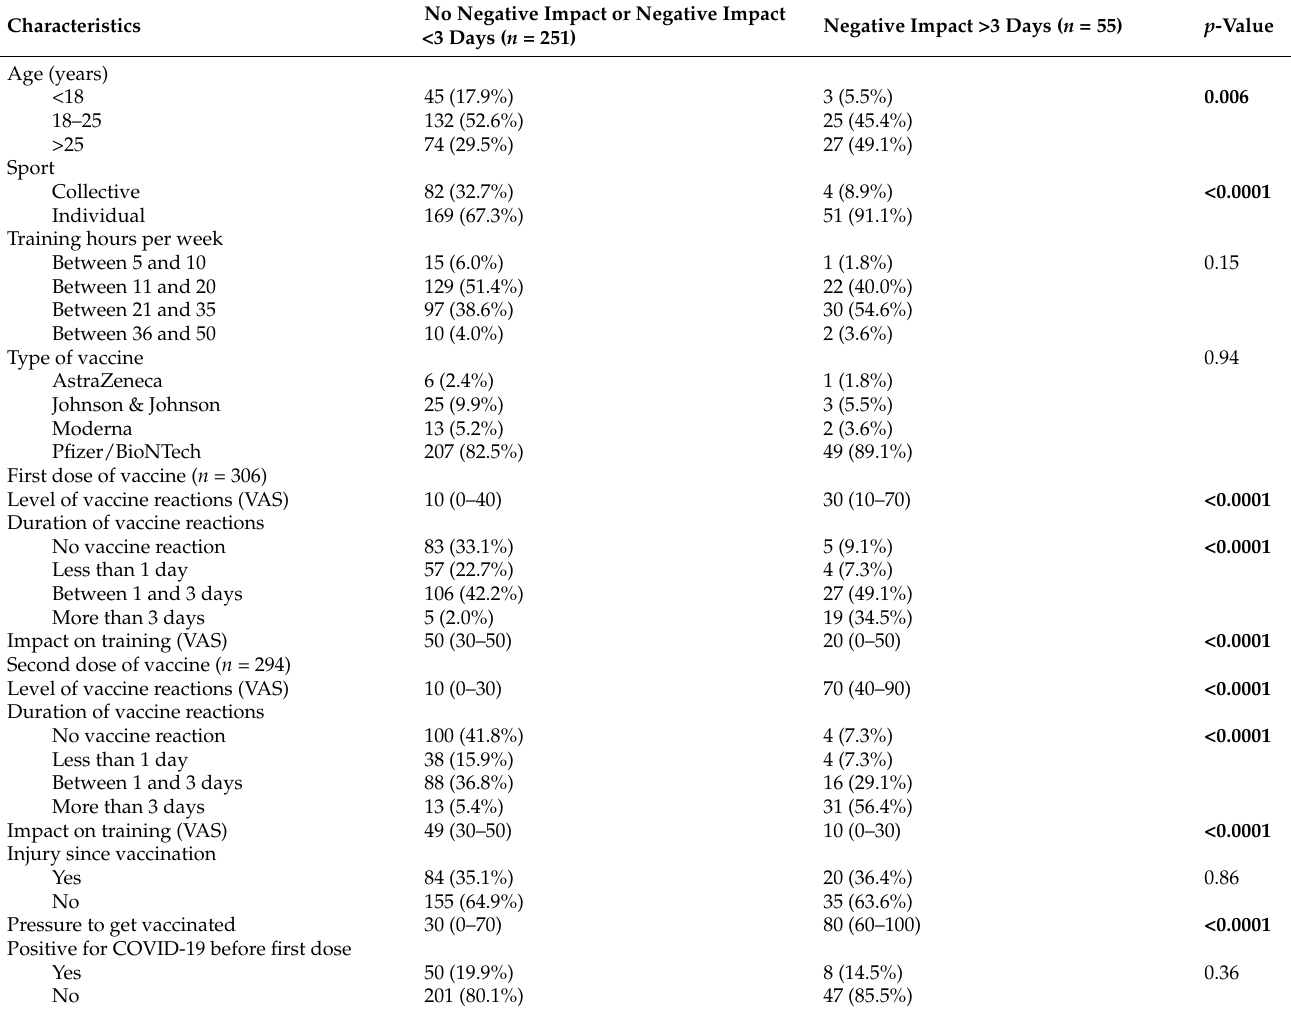
Table 3. Factors associated with the perceived negative impact on physical performance lasting more than 3 days after full COVID-19